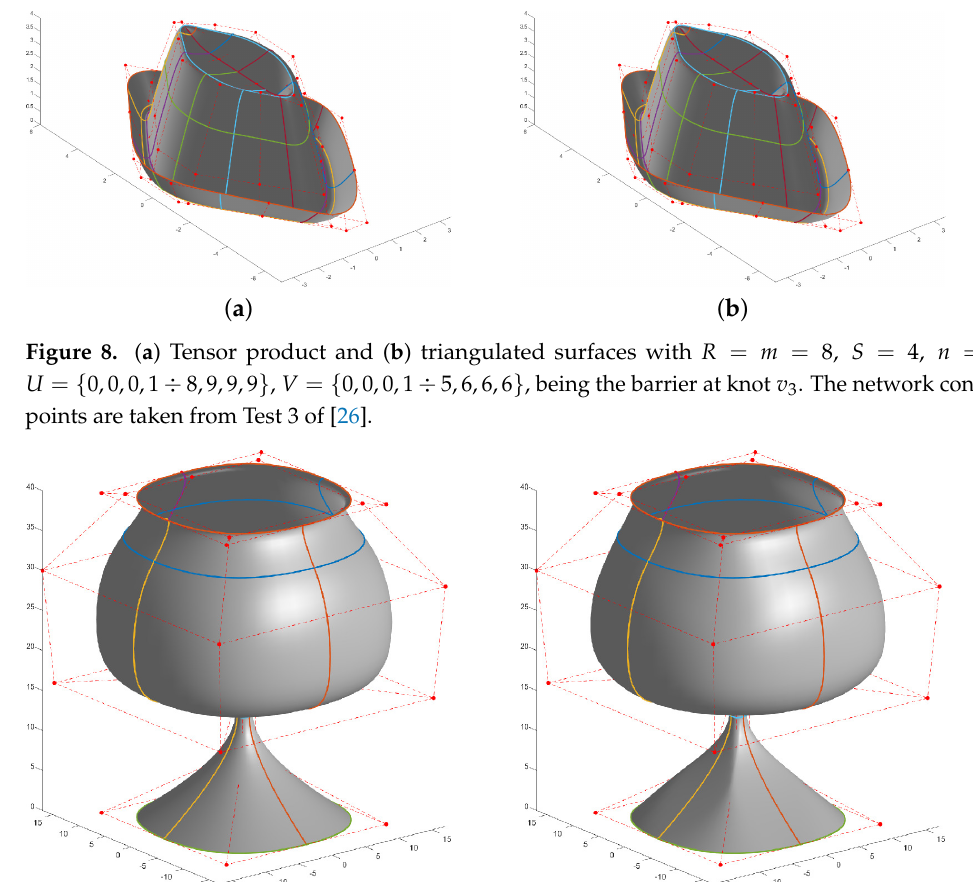
, being the barrier at knot v 3 . }